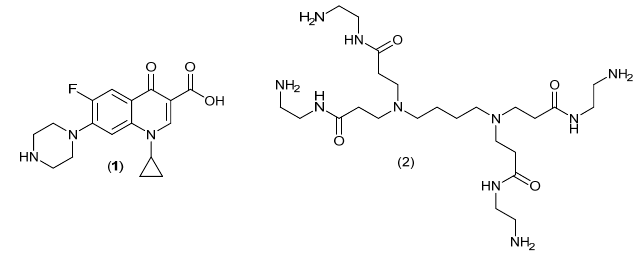
Figure 2. Ciprofloxacin ( 1 ) and the PAMAM-dendrimer ( 2 ).